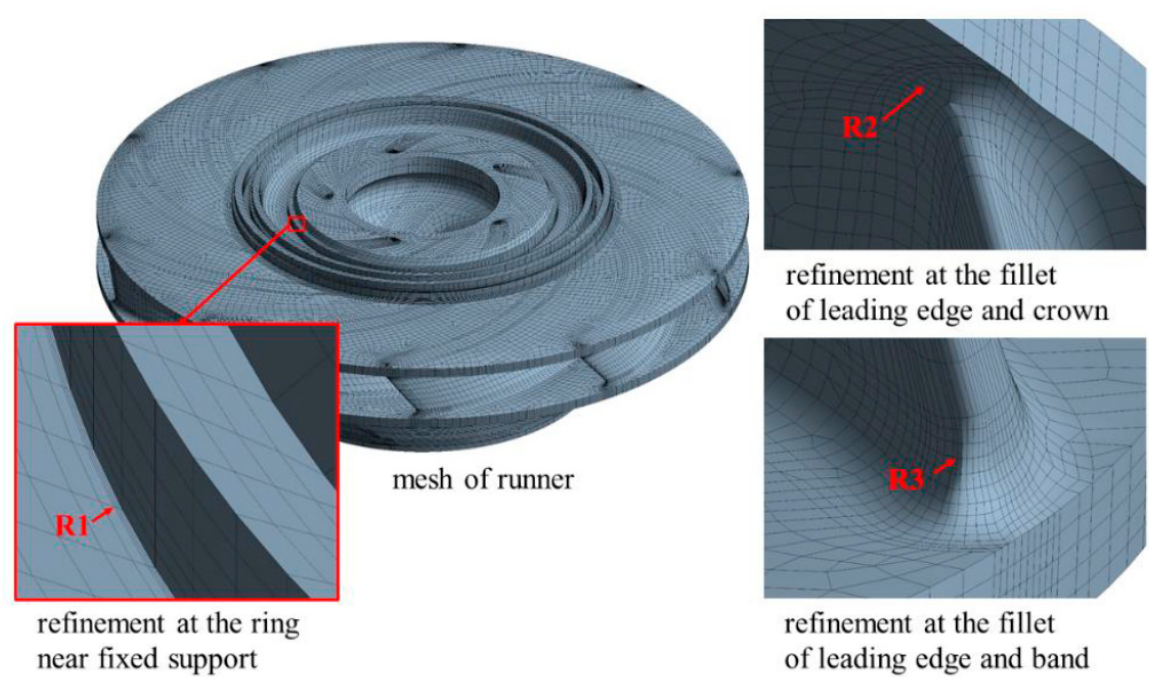
Figure 1. Finite element model of runner (R1 is the node at the ring near fixed support; R2 is the node at the fillet of leading edge and crown; R3 is the node at the fillet of leading edge and band).